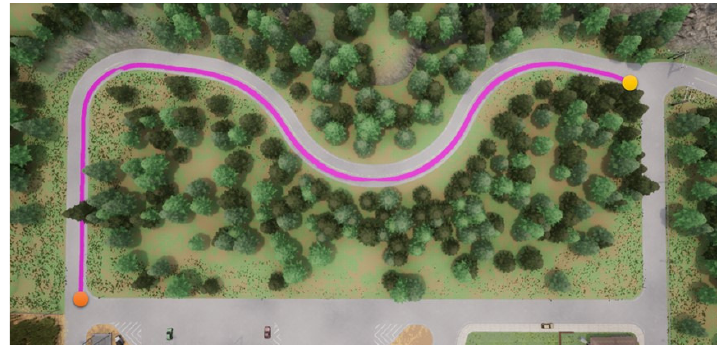
Figure 15. RDPG with a semantic segmentation camera for the first testing path.